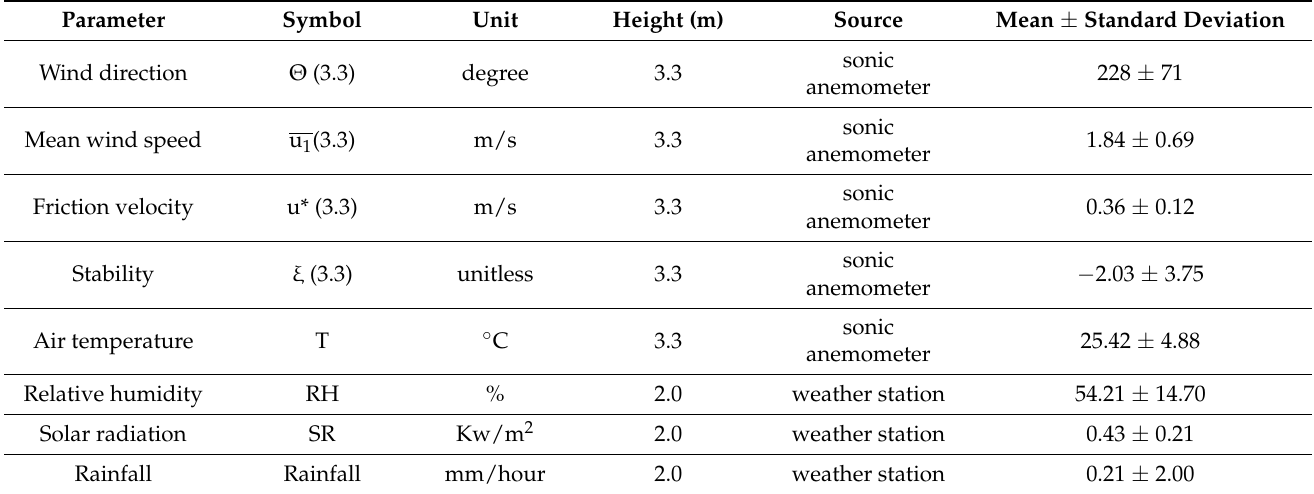
Table 2. Statistics of meteorological variables collected in the Illinois